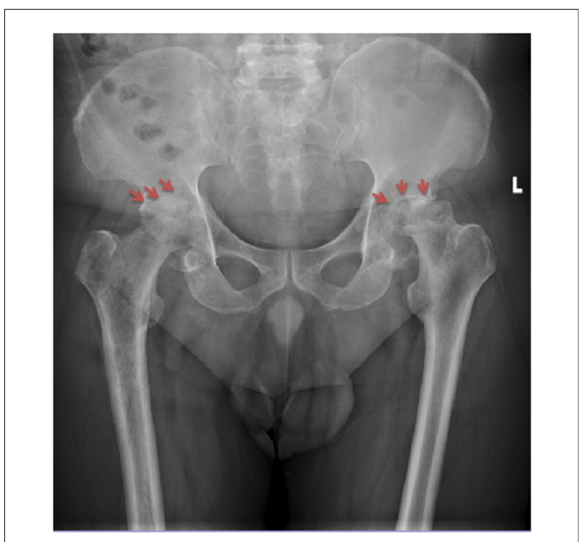
revealed severe joint space narrowing, disappearance of the acetabular sourcil, and bone destruction in the femoral head and femoral neck. Images were taken six months after the onset of hip pain and